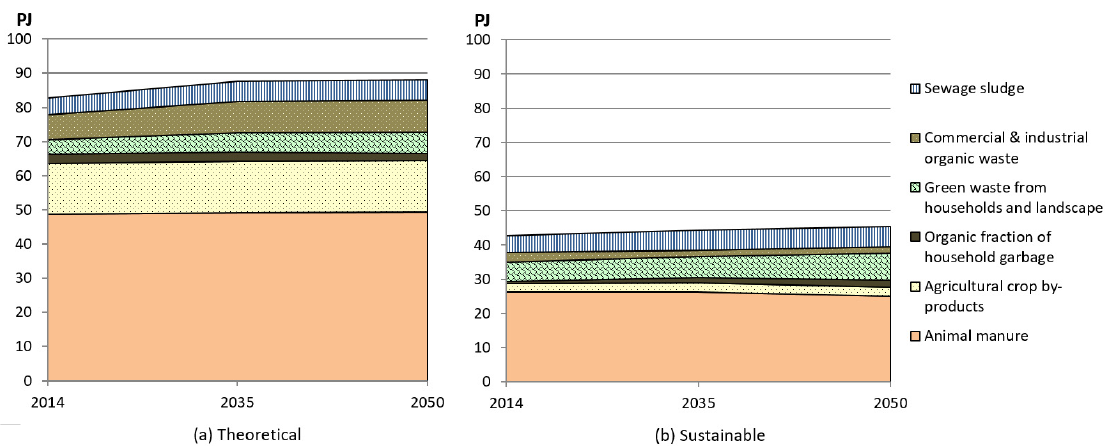
Figure 4. Cumulative mean of the expected development of biomass potentials in PJ in 2035 and 2050 from the Monte Carlo simulation: ( a ) theoretical; ( b ) sustainable.